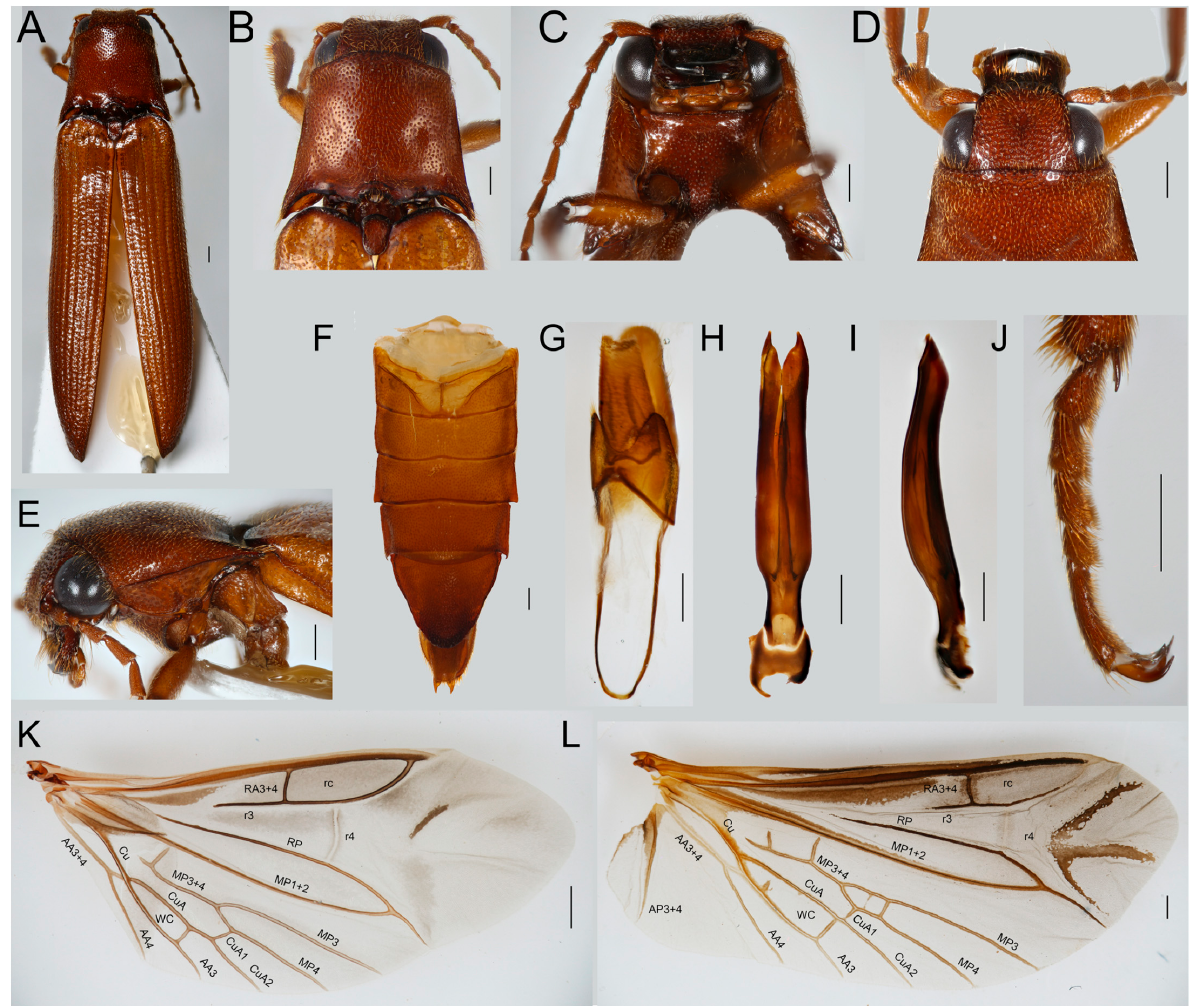
Figure 6. Eudicronychus rufus Fleutiaux, 1919. ( A ) General appearance, dorsal view; ( B ) head, prothorax and elytral humeri, dorsal view; ( C ) head and pronotum, ventral view; ( D ) head, dorsal view; ( E ) head, prothorax, and the base of elytra lateral view; ( F ) abdominal sterna; ( G ) terminal abdominal segments; ( H ) male genitalia, ventral view; ( I ) male genitalia, lateral view; ( J ) metatarsus; ( K ) metathoracic wing of Hapatesus tropicus ; ( L ) metathoracic wing of Dicronychus rufus Scales 0.5 mm. The vein designation follows [1].